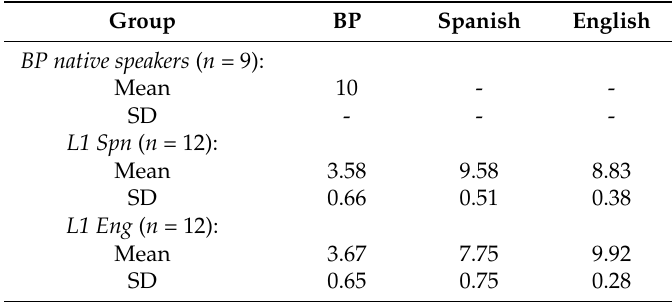
Table 1. Self-rated proficiency in BP, Spanish and English. Group BP Spanish English BP native speakers ( n =